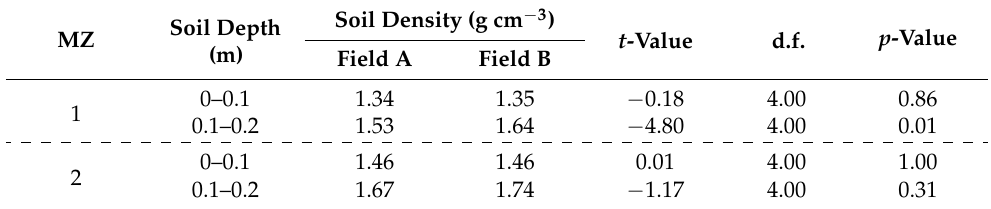
Table 4. Test of means for bulk soil density (Sd; g cm − 3 ), in two management zones (MZ 1 and MZ 2) delineated based on apparent soil electrical conductivity, according to the fields. Cachoeira do Sul, RS, BR. Soil Depth MZ